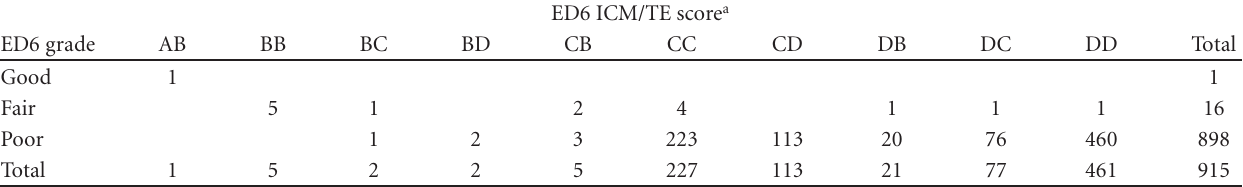
Table 1: Quality scores of 915 embryos graded B (blastocysts) or HB (hatching blastocysts) on ED6 and deemed unsuitable for clinical